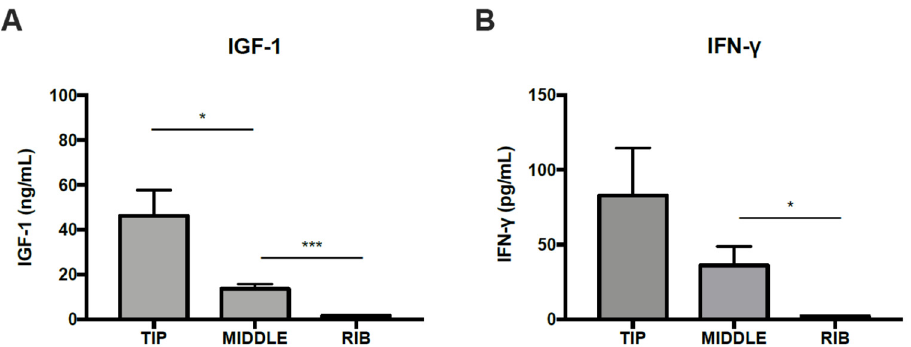
Figure 3. ( A ) Concentration of IGF-1 in two sections of antlers and internal bone (rib) as a control. ( B ) Concentration of IFN- γ in two sections of antlers and internal bone (rib) as a control. Data are means ± standard error of the mean. p -value of the significant compari- son against control (* p = 0.05–0.01, *** p ≤ 0.001).